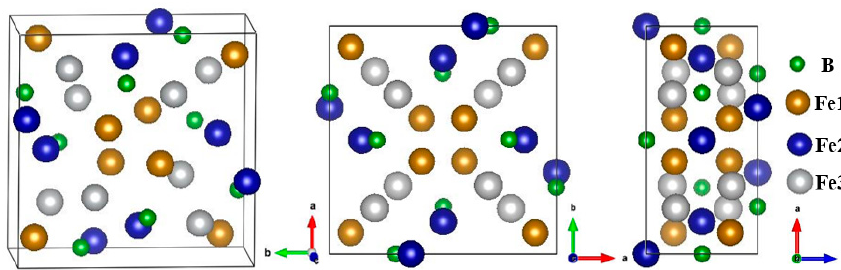
Figure 1. Crystal structure of Ni 3 P-type Fe 3 B.